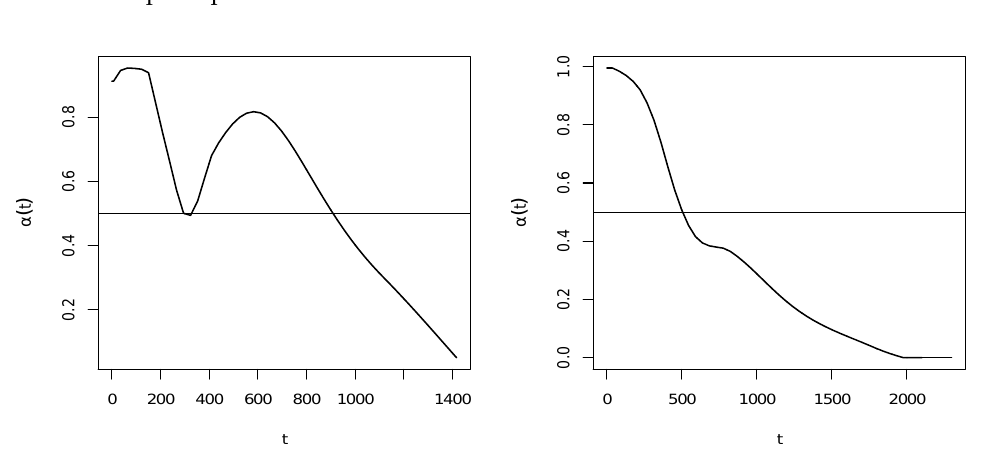
Figure 2. Non-censoring probability curves for Arm A ( left ) and Arm B ( right